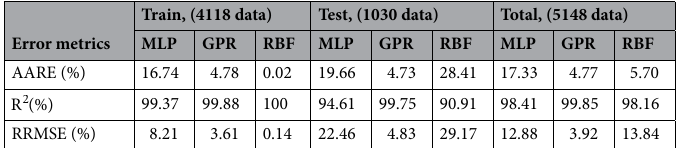
Table 3. Error metrics of the novel intelligent models for predicting H 2 S solubility in solvents.